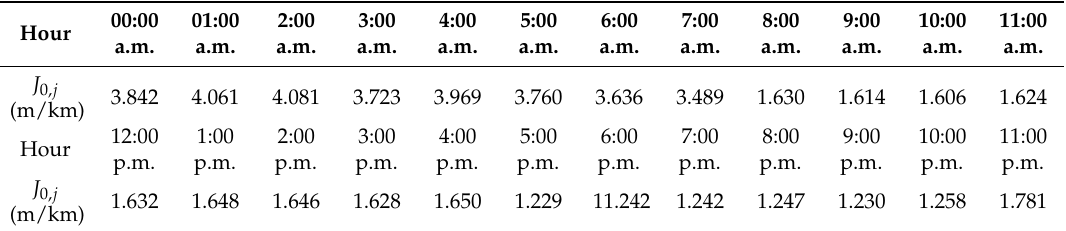
Table 1. J 0, j obtained for each period j .